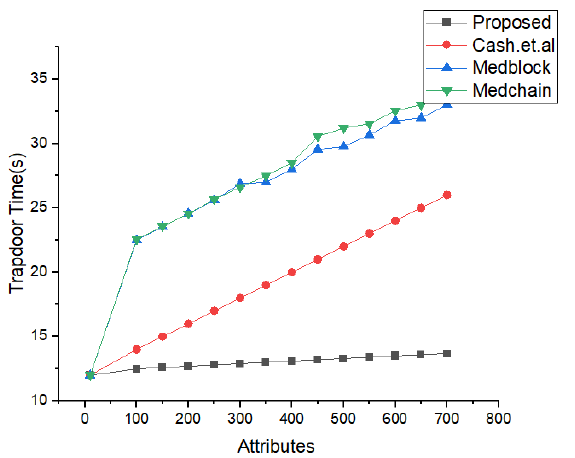
Figure 15. Trapdoor Generation Time using Homomorphic encryption-based keyword